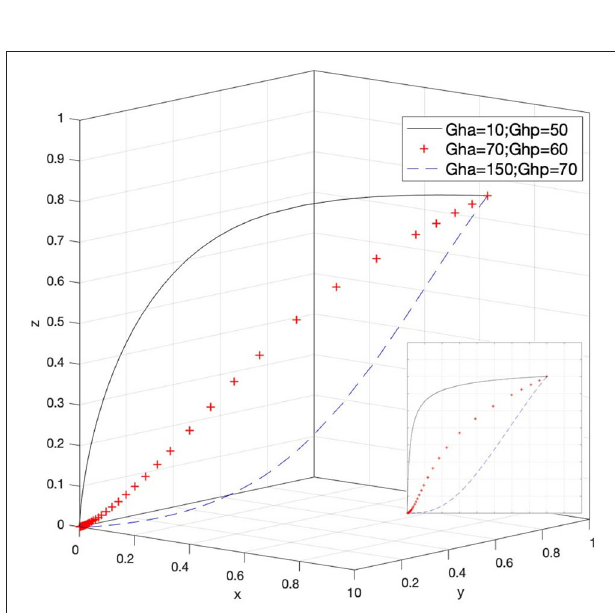
FIGURE 9 | Effect of the loss of rights holders’ active and passive rights protection.